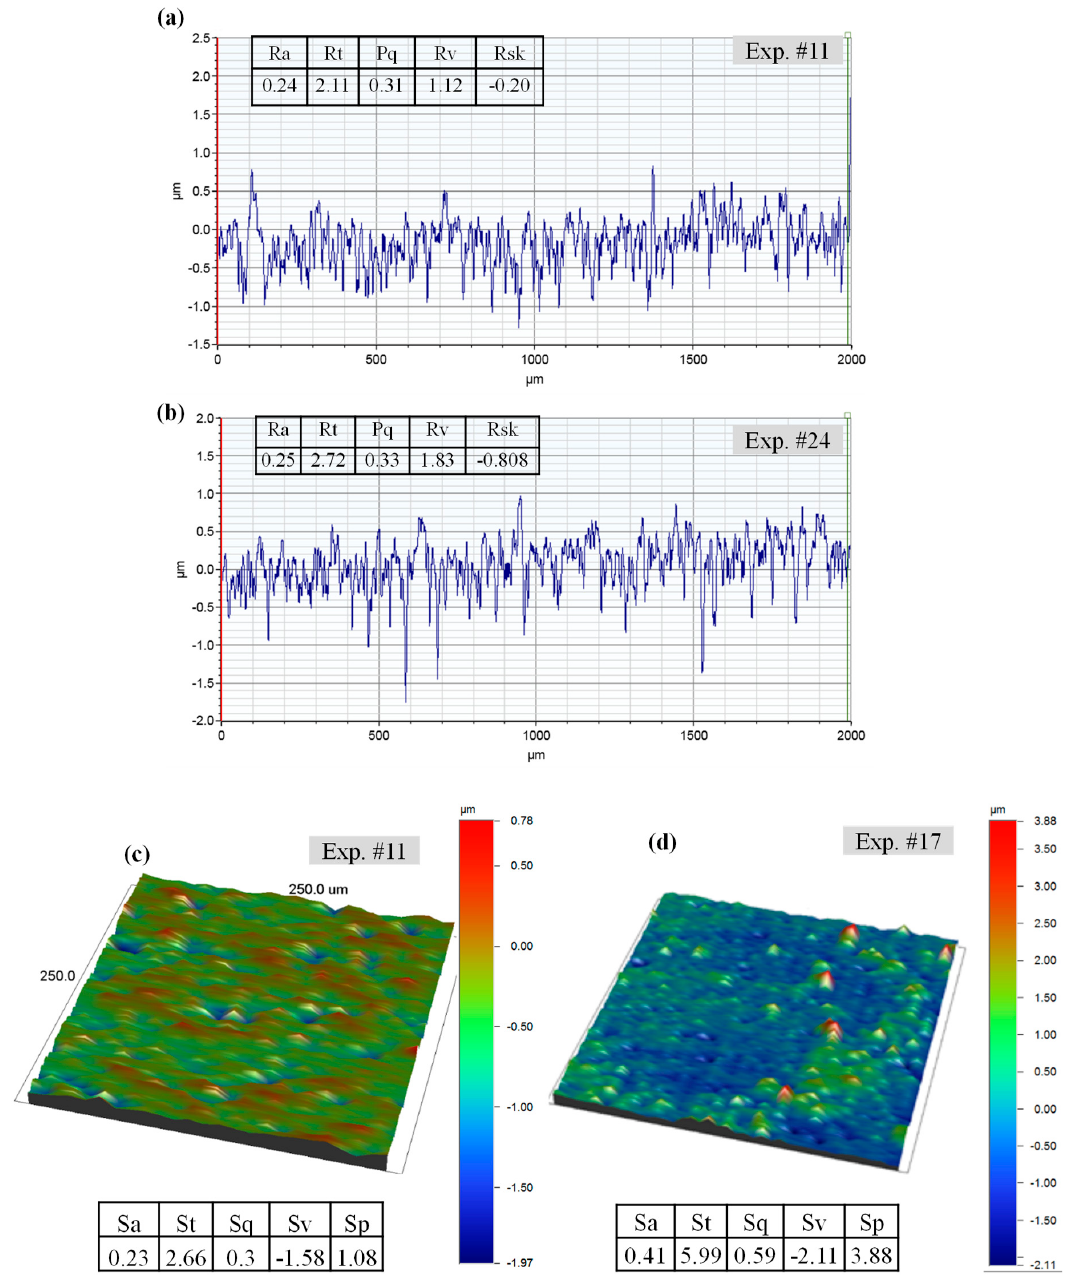
Figure 5. Example of typical scanned profiles milled at parameters of ( a ) 2D profile of Exp. #11, ( b ) 2D profile of Exp. #24, ( c ) 3D scanned area of Exp. #11, and ( d ) 3D scanned area of Exp. #24.